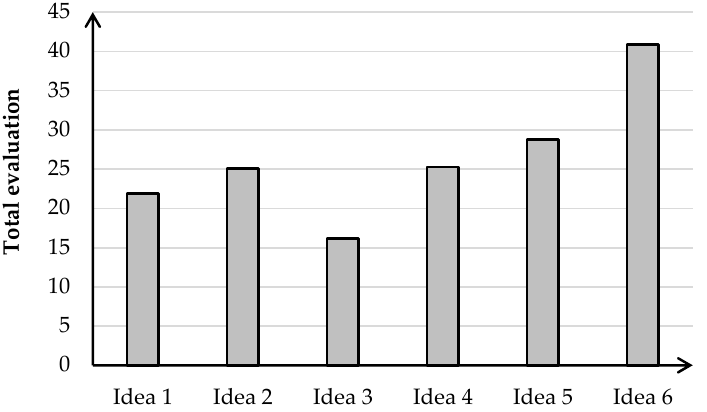
Figure 4. The total result of the evaluation process among main stakeholders of the company.